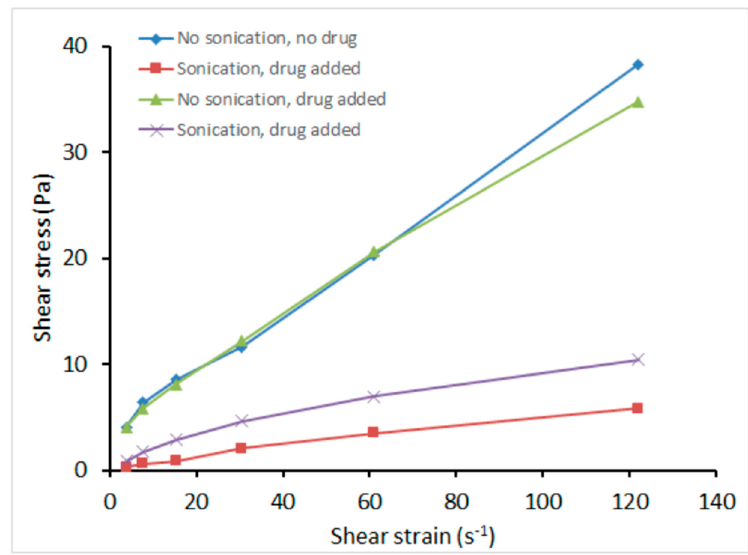
Figure 1. Rheology of non-sonicated and sonicated emulsions of SEDDS (60% w/w) without and with drug.